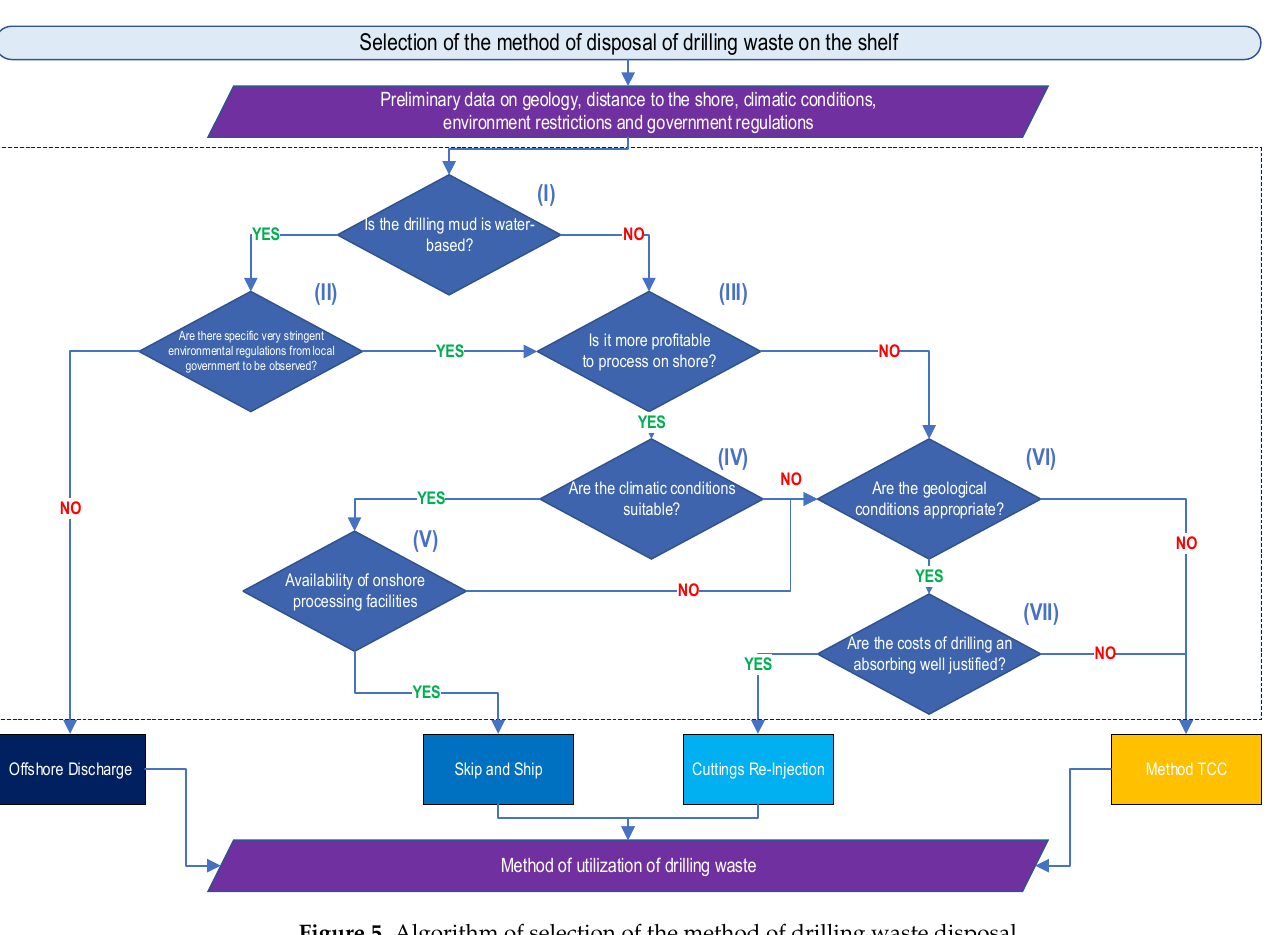
Figure 5. Algorithm of selection of the method of drilling waste disposal.